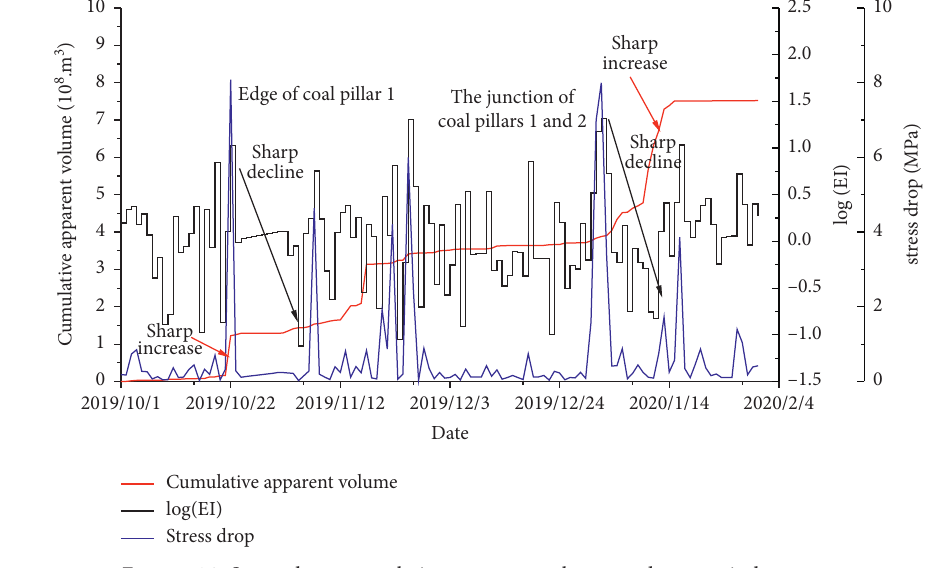
Figure 14: Stress drop, cumulative apparent volume, and energy index curves.